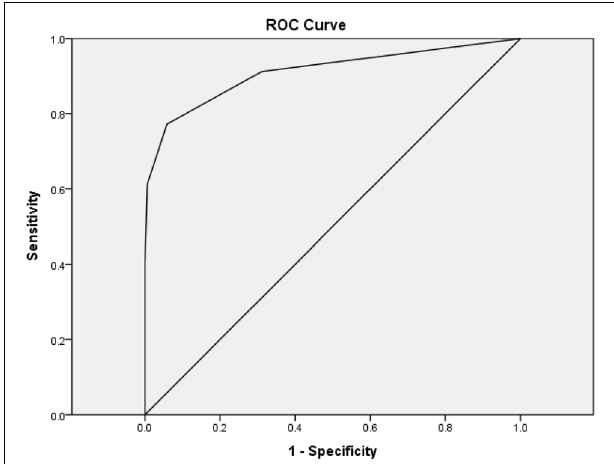
FIGURE 1 | Receiver–operating characteristic curves (ROC) of the HAI-VSQ for the discrimination of VSD in DLB and NDC. A cutoff score ≥ 2 was useful with a sensitivity of 0.77, a specificity of 0.94, and an AUC of 0.91.